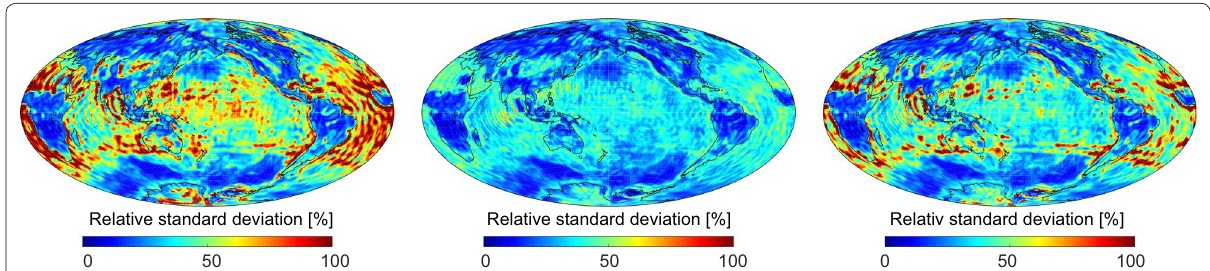
Fig. 4 Relative standard deviation of equivalent water height residuals over 4 years (2003–2006) derived from simulated true and noisy GRACE gravity field solutions using the DDK filter only and by applying the DDK filter and the global grid point gain factors: true − DDK filter (left), true − ( DDK filter, k org ) (middle) and true − ( DDK filter, k )